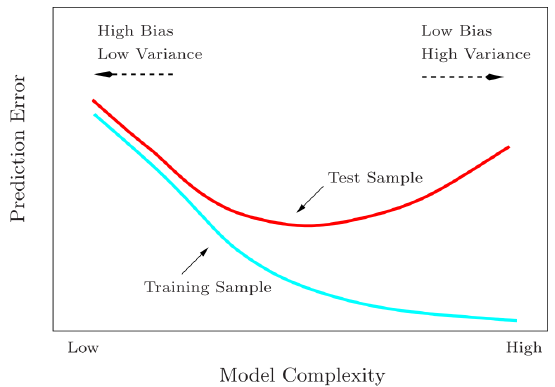
Figure A2. Prediction error of training and test dataset according to model complexity. A medium level of model complexity minimizes the prediction error of the test dataset (Figure quoted from [39]).